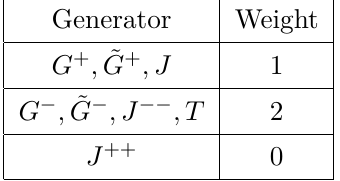
Table 2 . Conformal weight of the twisted small N = 4